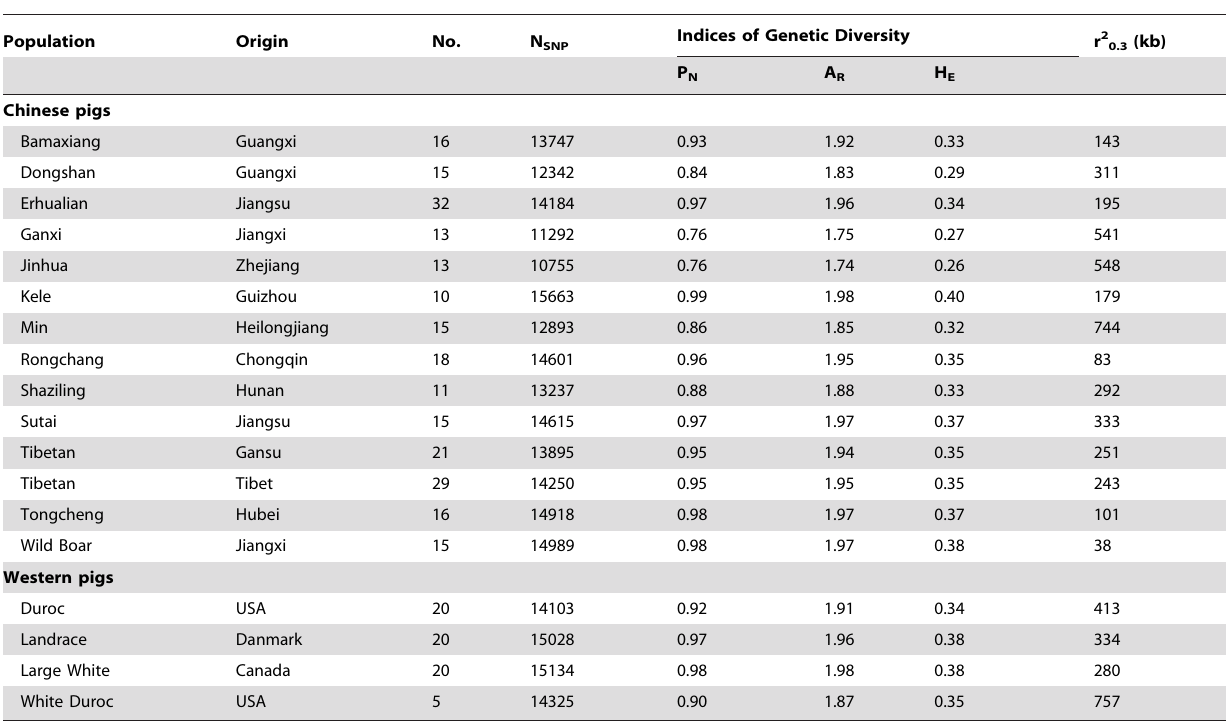
Table 1. Sample size, genetic diversity and LD extent of 18 Chinese and Western pig populations. a